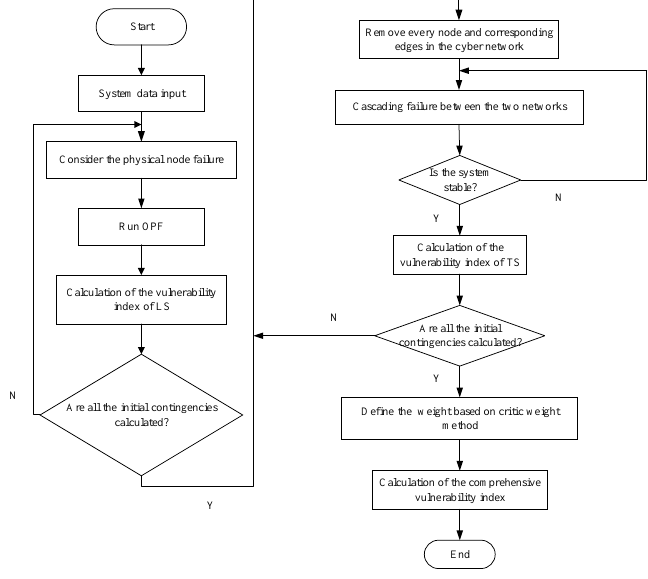
Figure 3. Flow chart of vulnerability